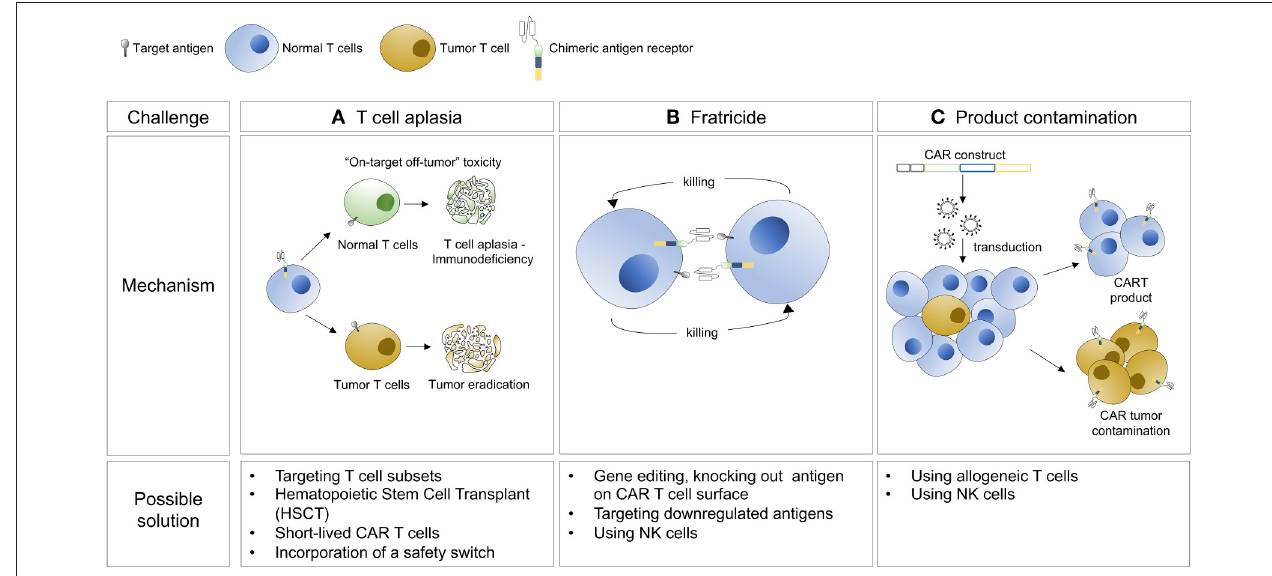
FIGURE 1 | Hurdles associated with the development of CAR T cell therapy for the treatment of CTCL and possible solutions.